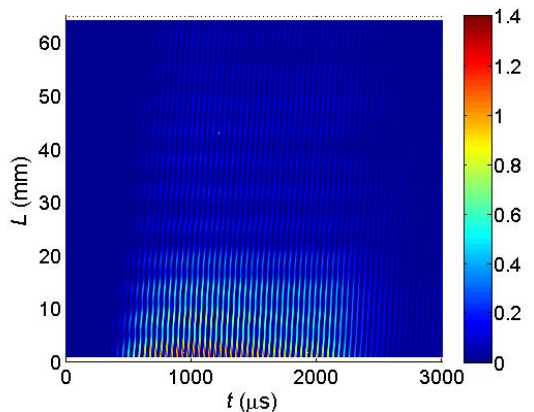
Figure 33. Measured B-Scan of the normal displacements of the PVC film when the optimised time delays between array elements were used. Sensors 2018 , 18 , x FOR PEER REVIEW